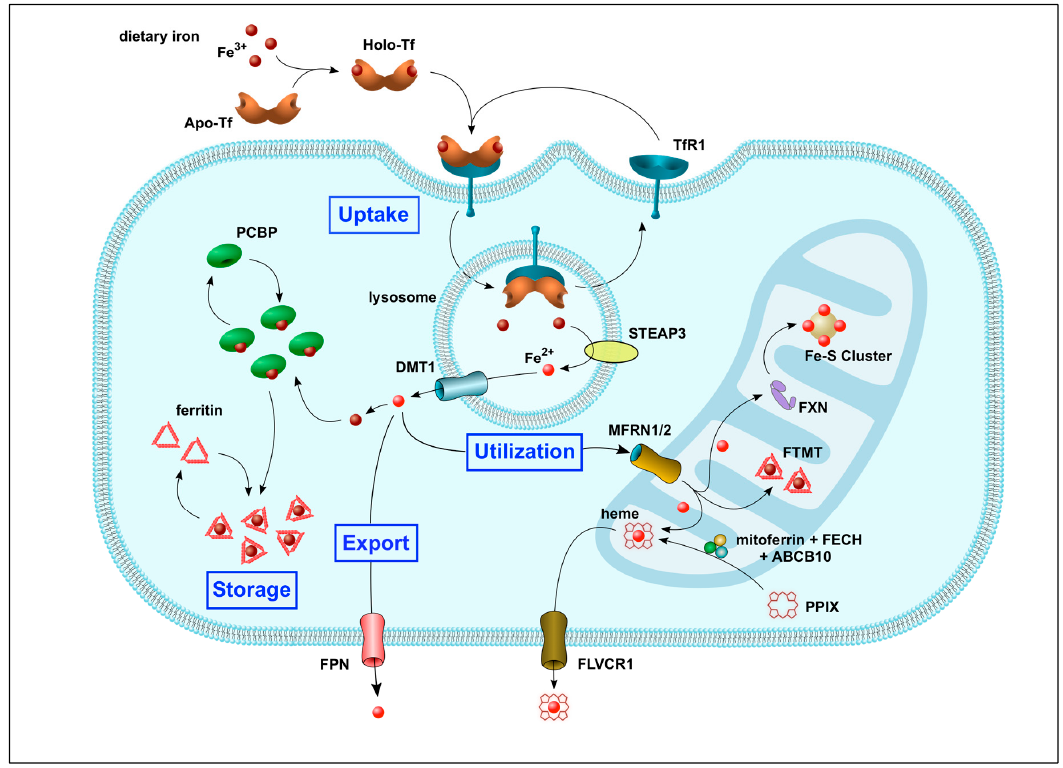
Figure 2. Schematic diagram showing iron import, export, utilization, and storage within cells.